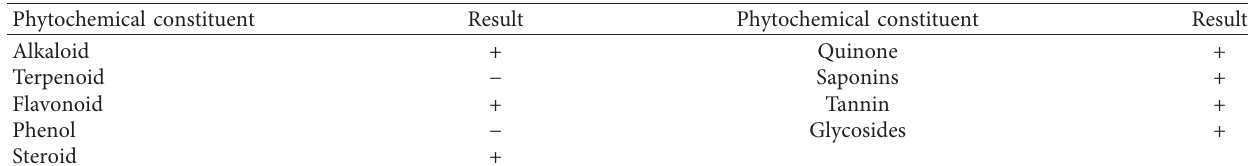
Table 1: The result of preliminary phytochemical screening of hydromethanolic extract of the corm of Ensete ventricosum (Welw.) Cheesman.